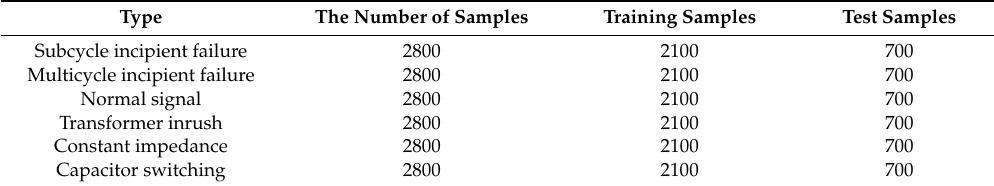
Table 2. The number of samples.